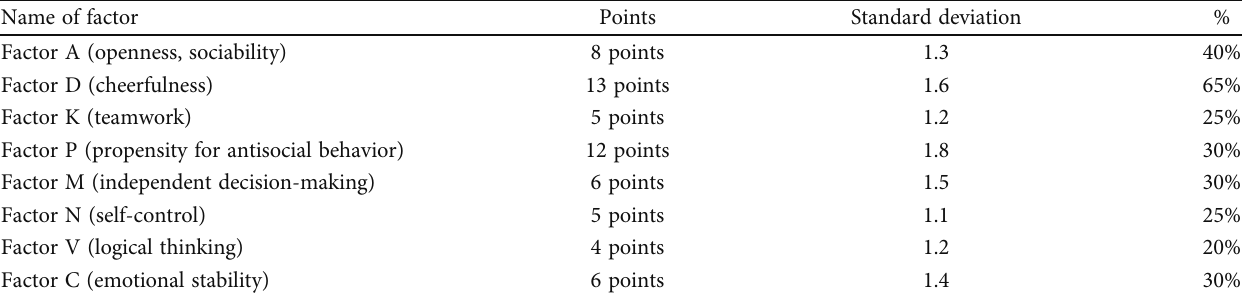
Table 1: Preliminary results.